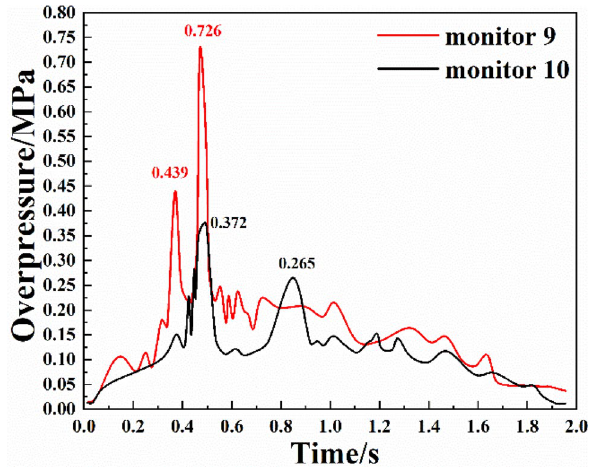
Figure 8. Overpressure change of bifurcation